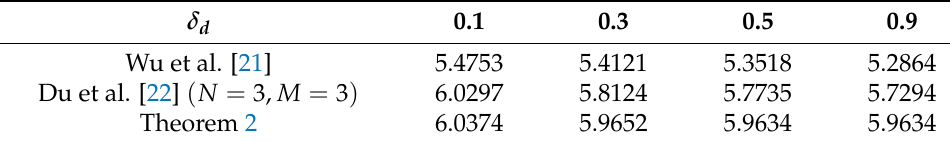
Table 3. The maximum upper bound of ρ for different δ d